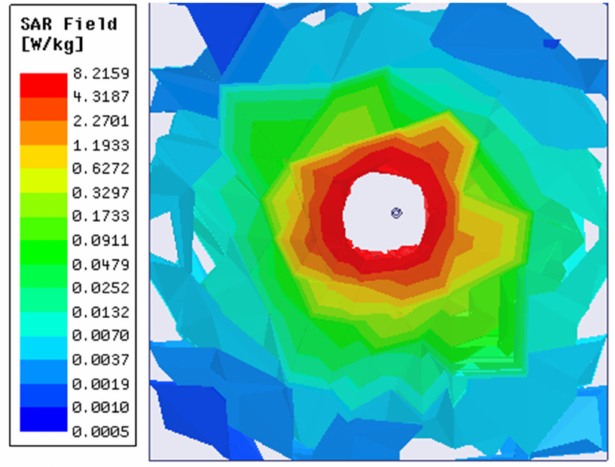
Figure 12. At 915 MHz, SAR distribution of the specified antenna inside the skin tissue over 1 g.